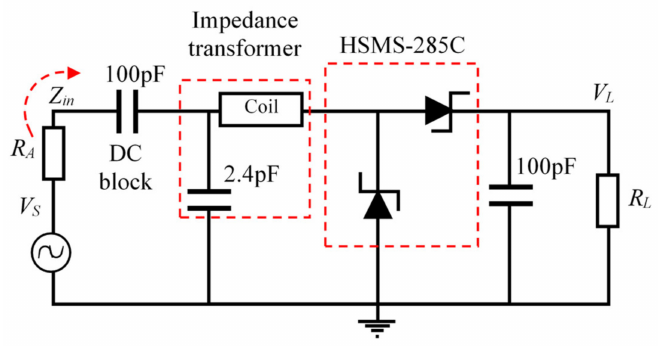
Figure 2. Radio frequency (RF) harvesting system using an HSMS-285C at 930 MHz [28].